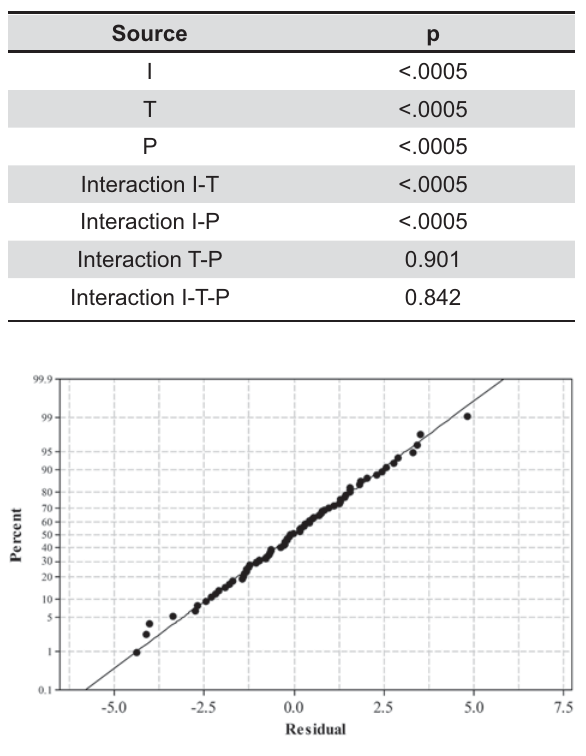
Table 2- (cid:8) &(cid:18)(cid:13)(cid:18)(cid:22)(cid:17)(cid:18)(cid:22)$(cid:13)’(cid:8) (cid:17)(cid:22)(cid:27)(cid:3)(cid:22)*$(cid:13)(cid:3)$(cid:12)(cid:8) (cid:2) p ) of the interactions of thickness (T), irradiation time (I) and post-curing (P) tested in the investigation